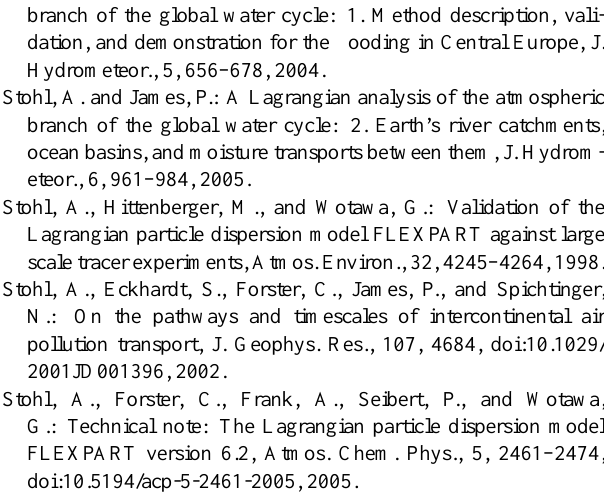
branch of the global water cycle: 1. Method description, vali- dation, and demonstration for the flooding in Central Europe,